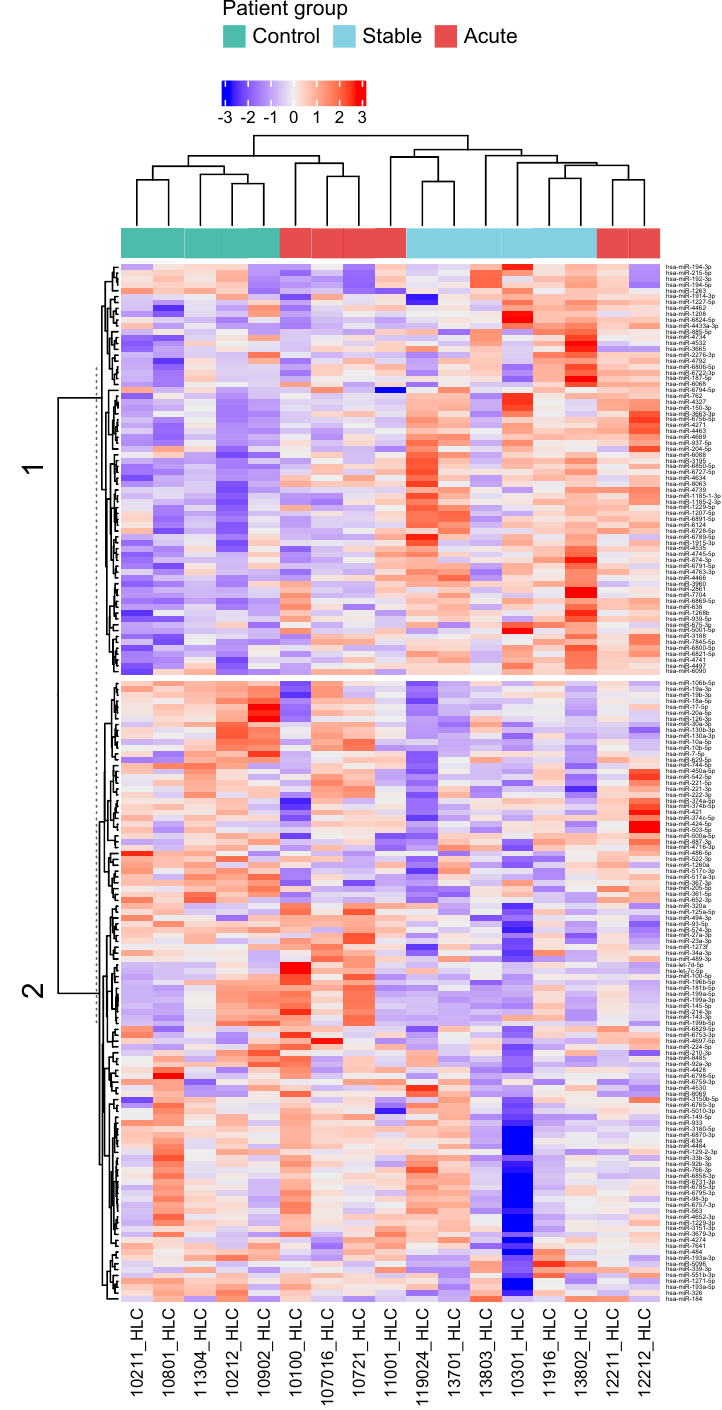
Figure 3. Heatmap of differentially expressed miRNAs ( p < 0.05) in HLCs based on miRNA microarray. Heatmap also includes miRNAs expressed only in one or two patient groups. Cluster 1 contains miRNAs that were up-regulated in most of the CAD cell lines and cluster 2 contains miRNAs that were mostly down- regulated in the CAD cell lines compared to the control group. HLC, hepatocyte-like